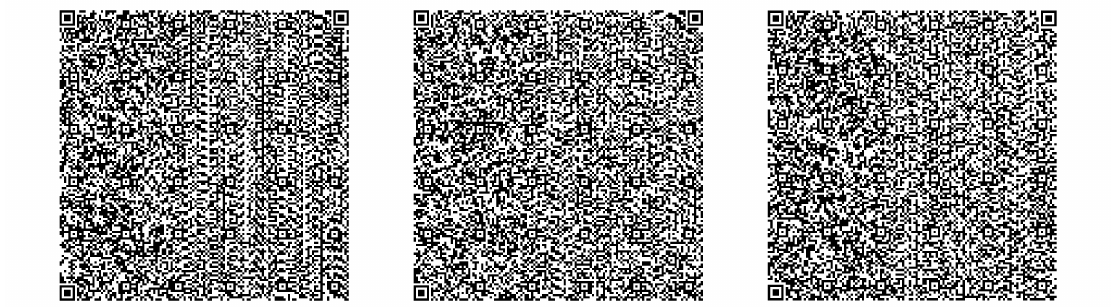
Figure A2. QR codes with the positions ( x , y ) and excitations ( a ) of the radiators for the 310 elements sparse layout.